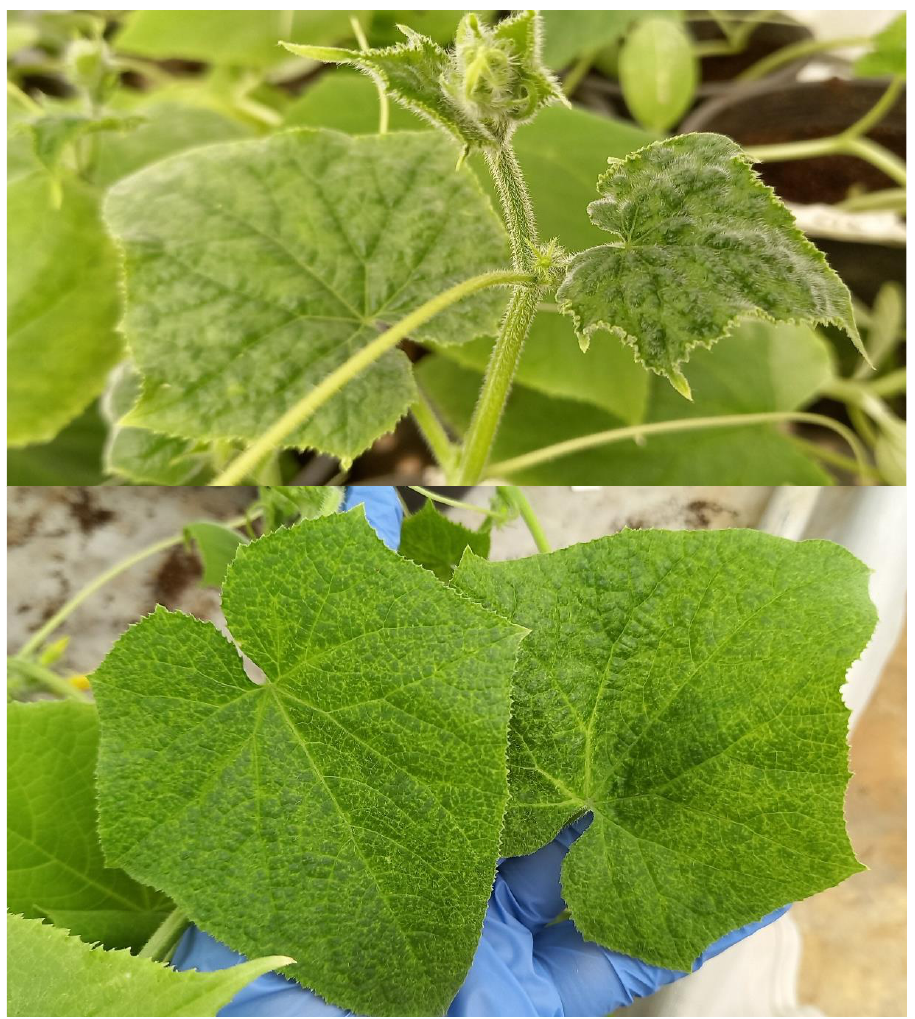
Figure 2. Blistering and mosaic symptoms of CMV on cucumber leaves. Table 2. ELISA absorbance measurements (405 nm) of CMV-inoculated plants at different Dpi.